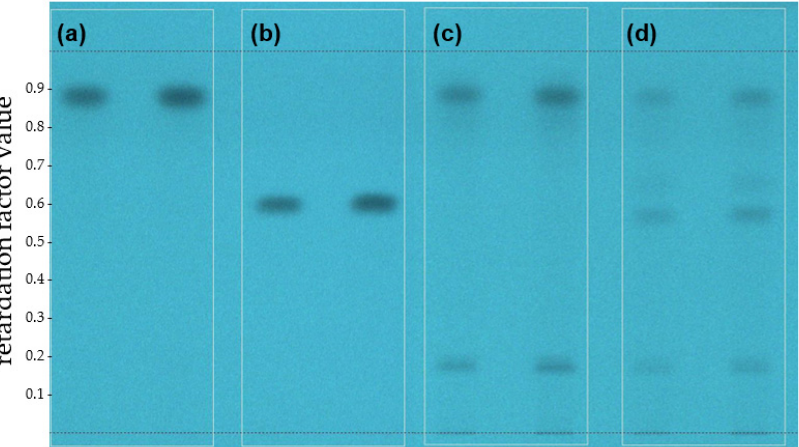
Figure 3. Photoconversion in vitro of MeO-MBM by HPTLC. HPTLC picture at 254 nm and with an injection volume of the respective samples of 20 µL (left) and 30 µL (right). ( a ) Avobenzone before irradiation. ( b ) MeO-MBM before irradiation. ( c ) Avobenzone after irradiation at 250 kJ/m 2 , and ( d ) MeO-MBM after irradiation at 250 kJ/m 2 .